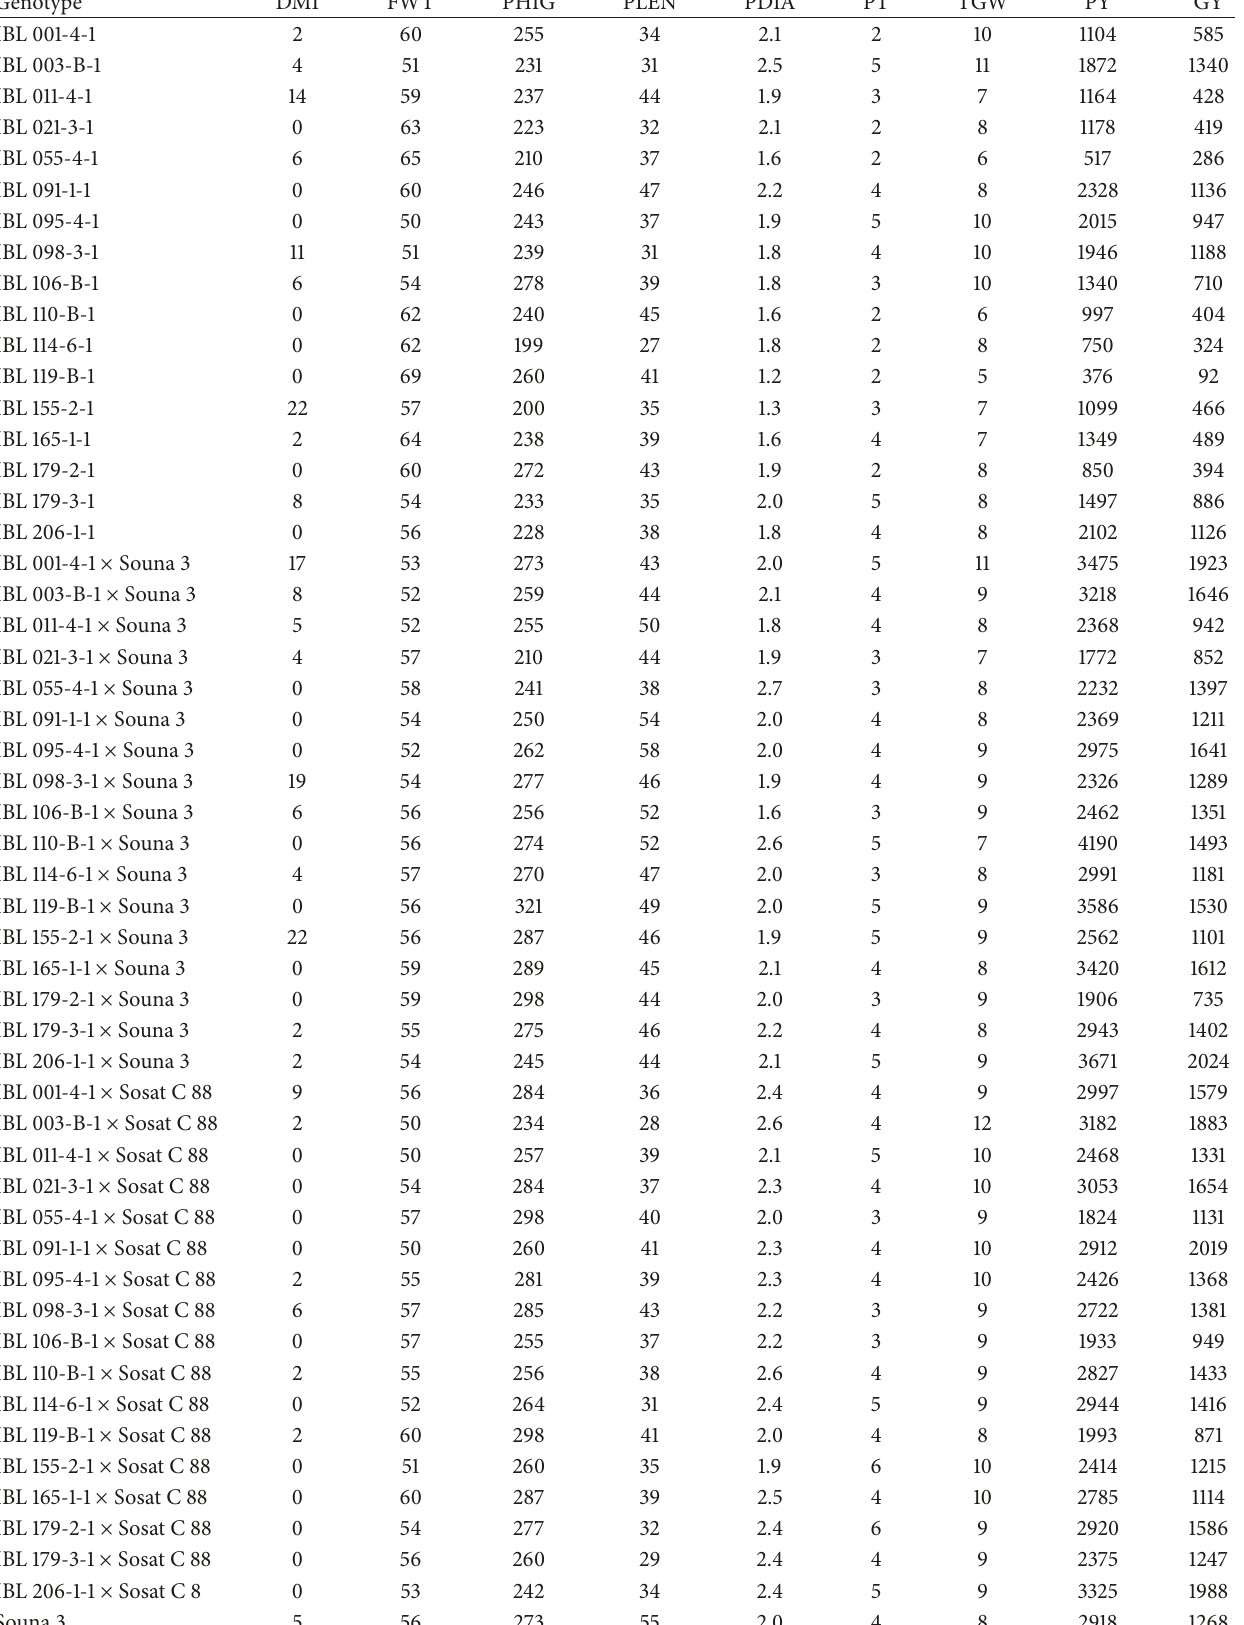
Table 3: Performance of tested genotypes for studied traits across